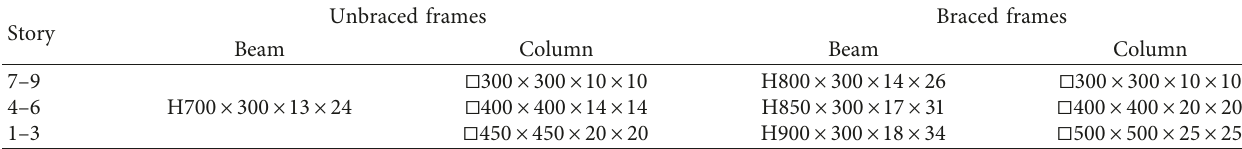
Table 3: Geometric detail of beams and columns of the 9-story frames.